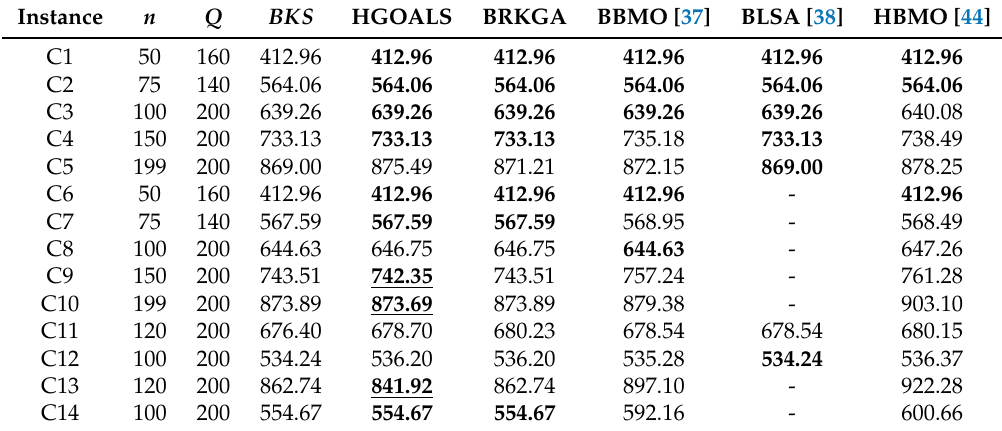
Table 7. Comparison between the HGOALS and previous research for instances in group C (minimizing traveling cost).